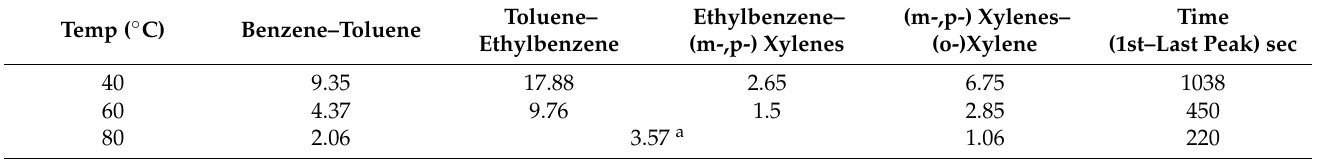
Figure 9. Chromatograms obtained with the μGC coupled to our spectrometer for 10 ppm of BTEX components at column temperatures ( a ) 40 °C, ( b ) 60 °C, and ( c ) 80 °C. Table 2. Peak-resolution values for BTEX components at different